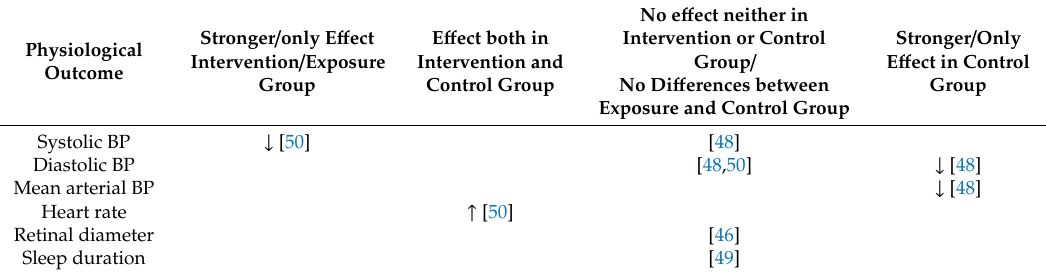
Table legend: ↑ positive association; ↓ negative association. Table 4. E ff ectiveness and physiological outcomes of GE.